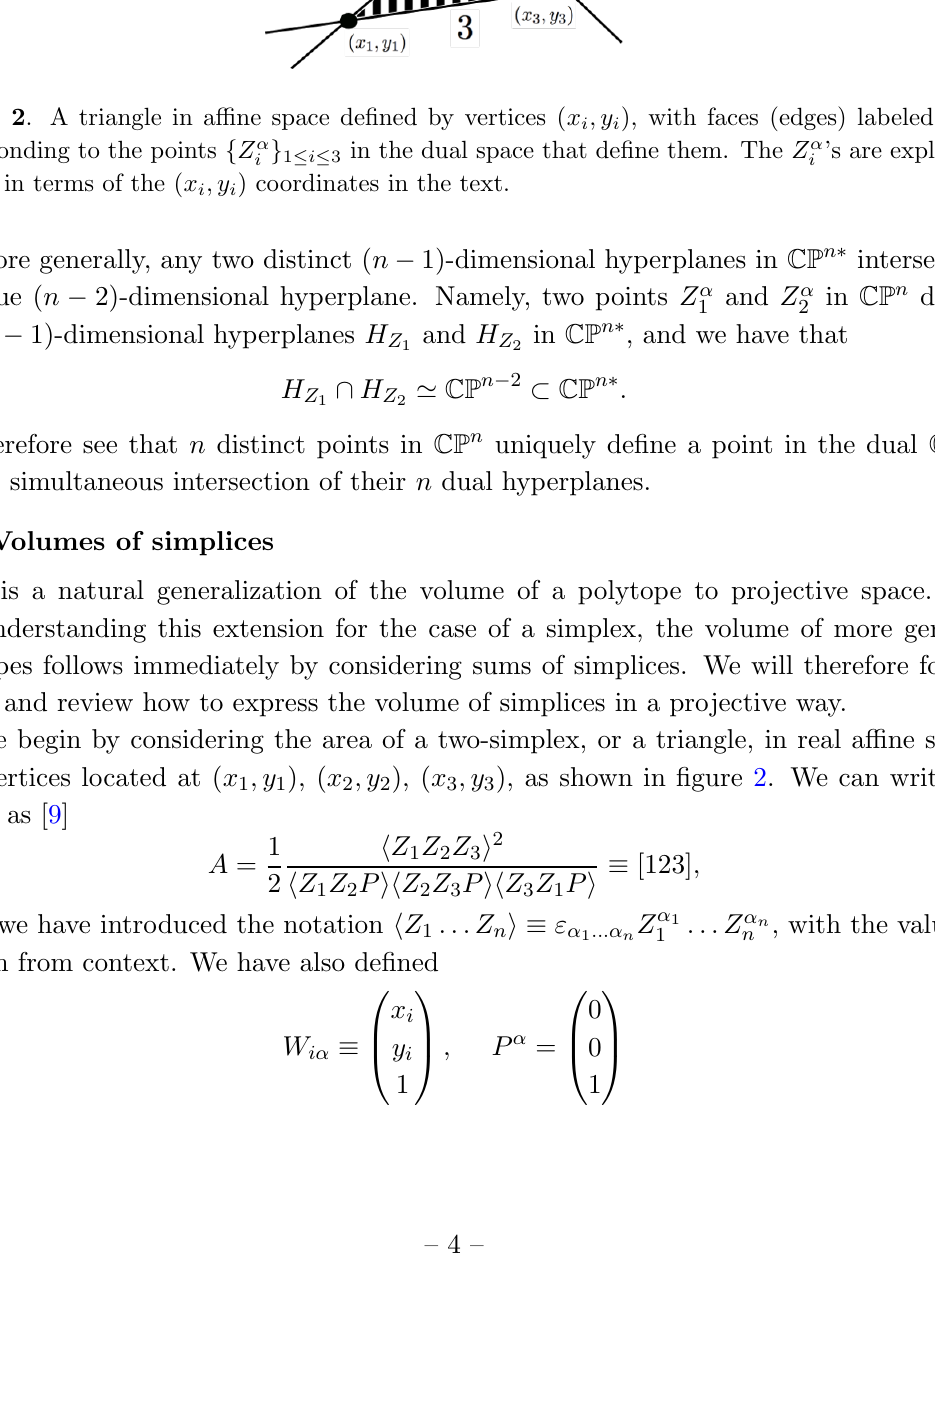
’s are explicitly i